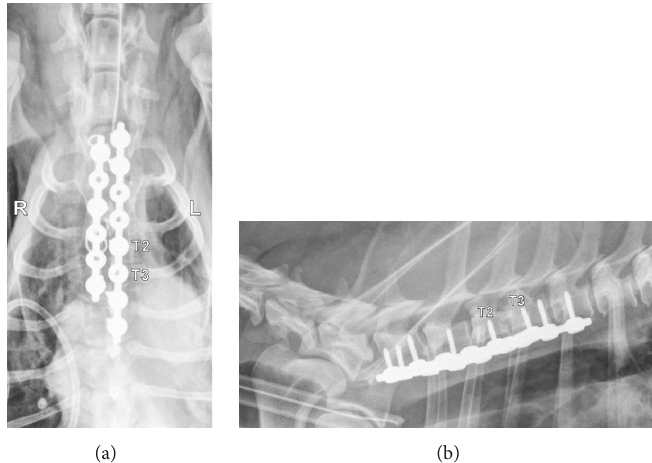
Figure 6: (a)Postoperativeventrodorsalradiographic projection of thecranial thoracicspineat thelevelof the spinal subluxation.Juxtaposed string of pearl plates are secured from the C7 to T4 vertebral bodies. The 8-hole plate on the dog’s left engages vertebral bodies C7, T2, T3, and T4. The 6-hole plate on the dog’s right side engages vertebral bodies C7, T1, and T3. Two wires are noted from the medial sternotomy closure superimposed over the 6-hole plate. (b) Postoperative lateral radiographic projection of the cranial thoracic spine at the level of the spinal subluxation. Screws are noted to engage vertebral bodies of C7-T2 cranial to the injury. Three screws engage vertebrae T3 and T4.